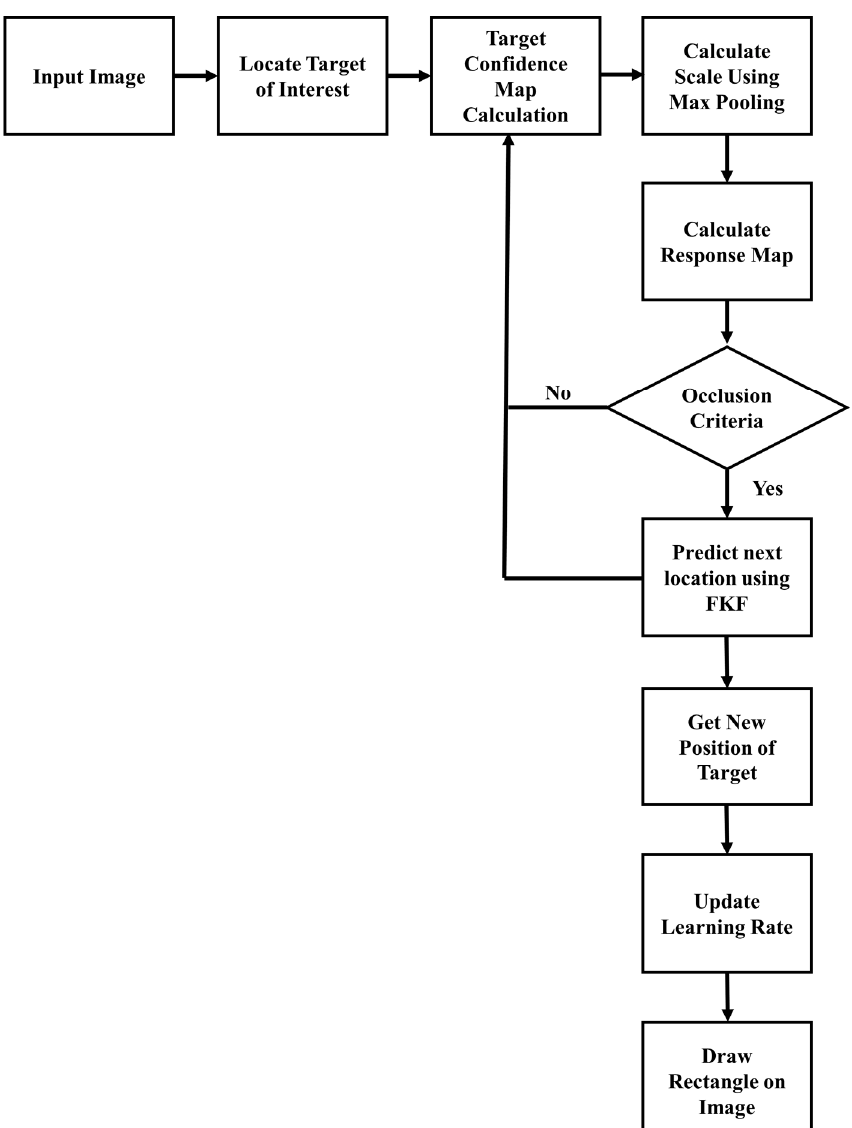
Figure 3. Flowchart of proposed tracking method.